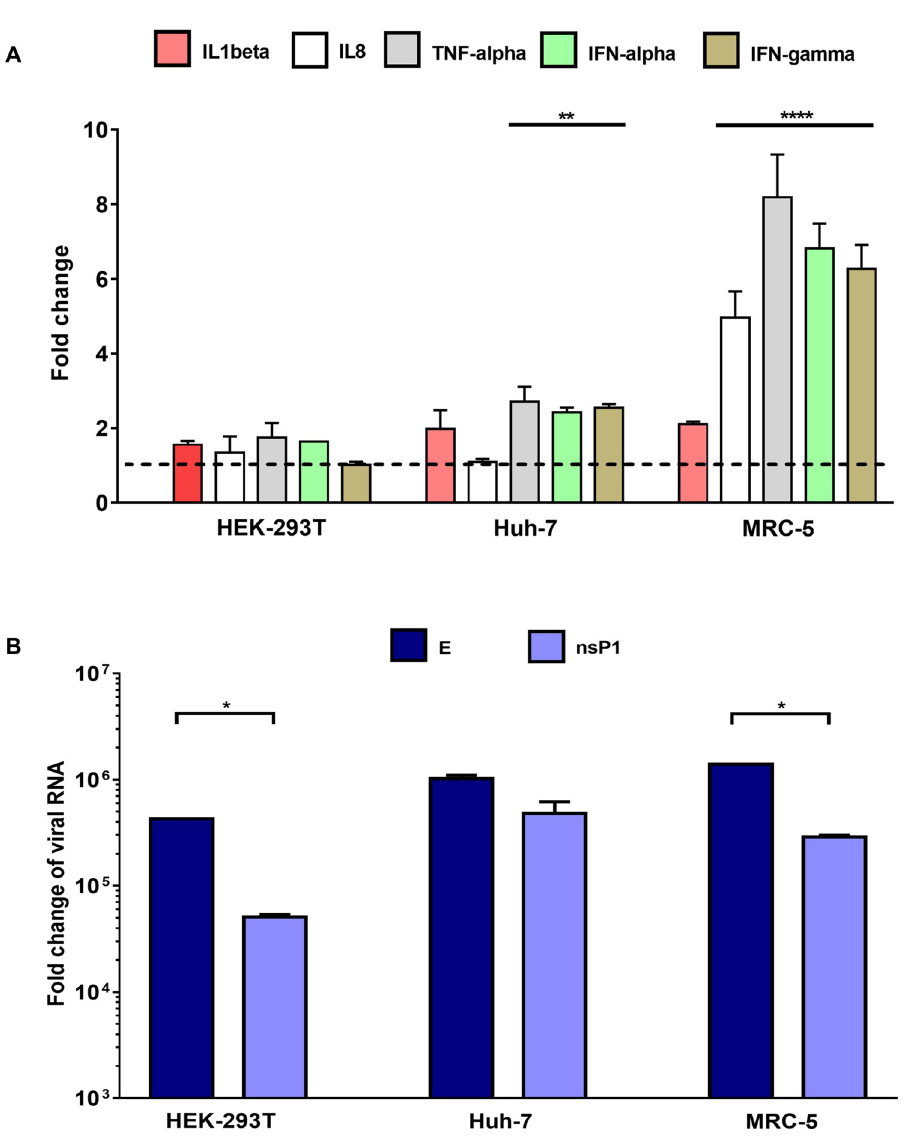
Fig 5. Gene expression levels of pro-inflammatory genes in CHIKV infected cells. Cells were infected at MOI 1 for 24 hpi and the RNA extracts were analyzed by RT-qPCR. Fold-change in mRNA levels of TNF- α , IFN- α , IL-1 β , and IL-8 were calculated using mock-infected cells as control (A). Viral RNA levels (B). Data were analyzed with the One- way ANOVA test. Statistically significant differences are indicated: �� P < 0.01; ��� P < 0.001; and ���� P < 0.0001.